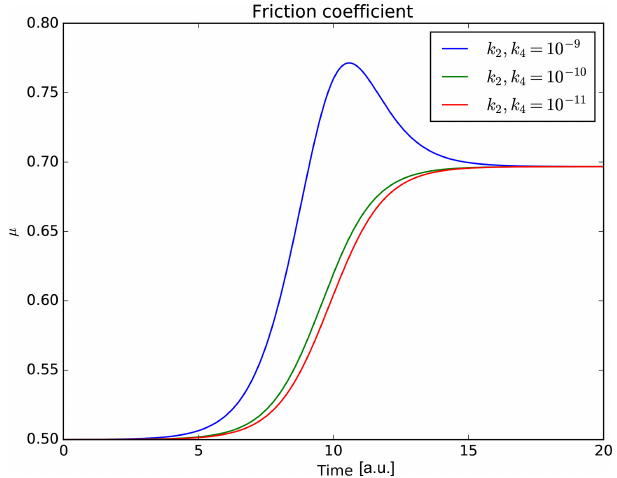
Figure 3. Temporal behavior of the semibrittle–plastic friction co- efficient using different parameters. In all the cases it is possible to observe an increase in the friction before earthquake ( t = 10a.u.). However, the friction decreases after the earthquake only if k 2 and k 4 have values of ∼ 10 − 9